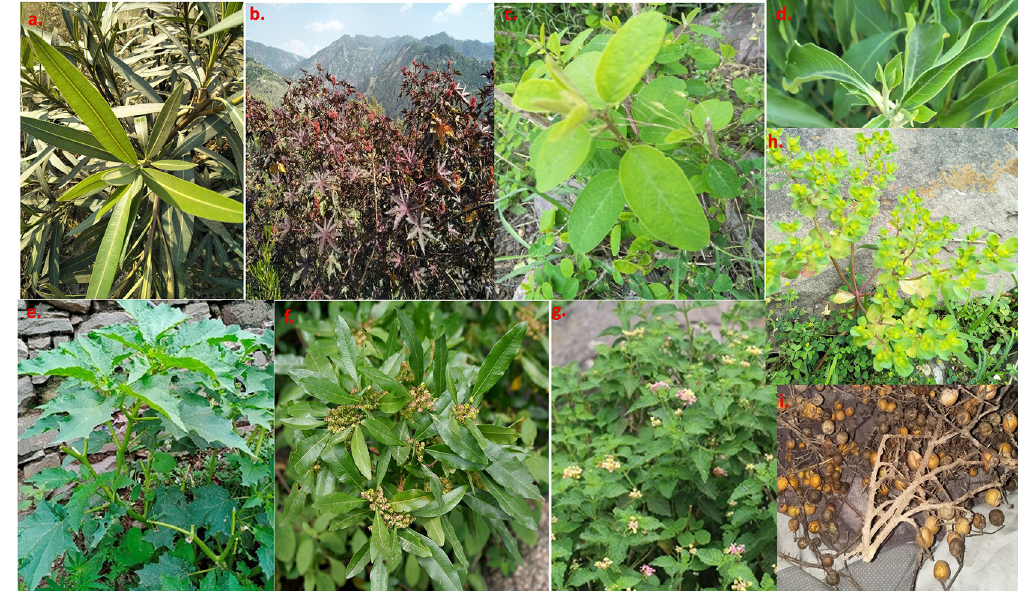
Fig 2. Pictorial view of some highly poisonous plants based on their LD50 values and respondent scores. a. Nerium oleander , b. Ricinus communis , c. Leptopus cordifolius , d. Justicia adhatoda , e. Datura stramonium , f. Dodonaea viscosa , g. Lantana camara , h. Euphorbia helioscopa , i. Solanum surattense .